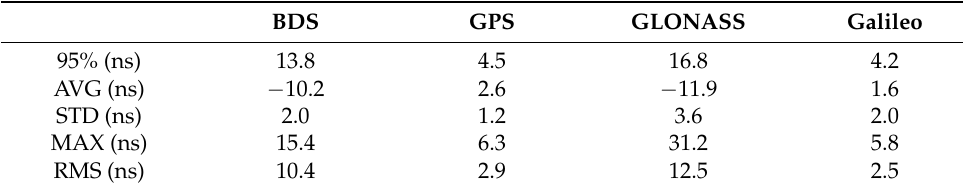
Table 3. The assessment results of GNSS time transfer